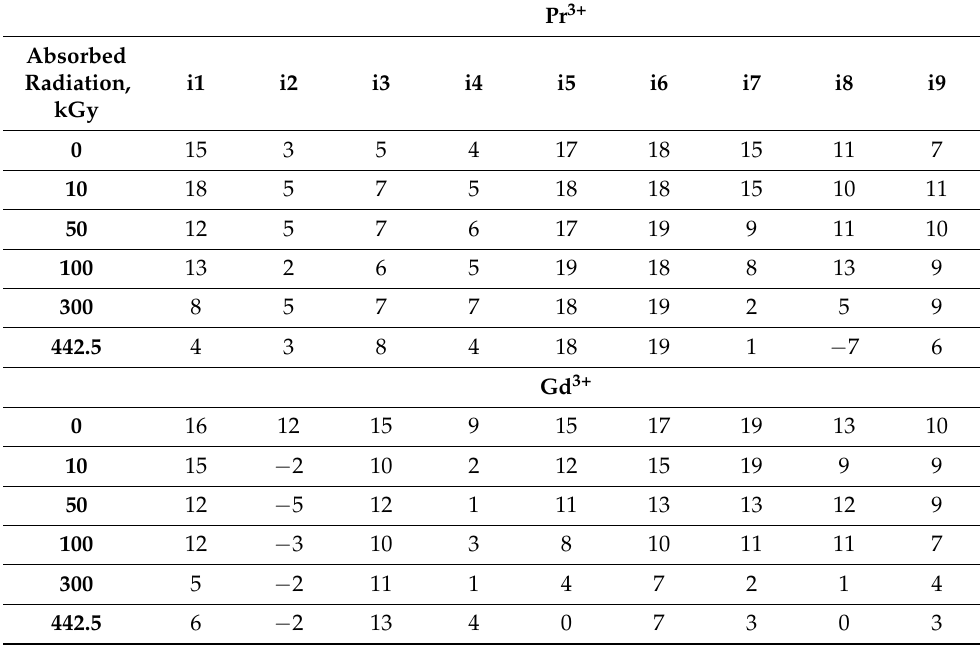
Table 2. Potentiometric sensitivity of the sensors after accumulation of various absorbed radiation doses (±1 mV/dec).